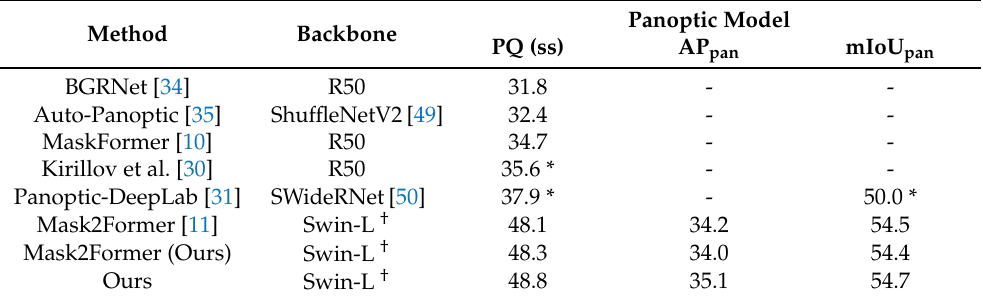
Table 6. Performance comparison of panoptic segmentation on the ADE20K validation dataset. Single-scale (ss) inference is adopted by default. Multi-scale results are marked with *. †: backbone pretrained on ImageNet-22K.